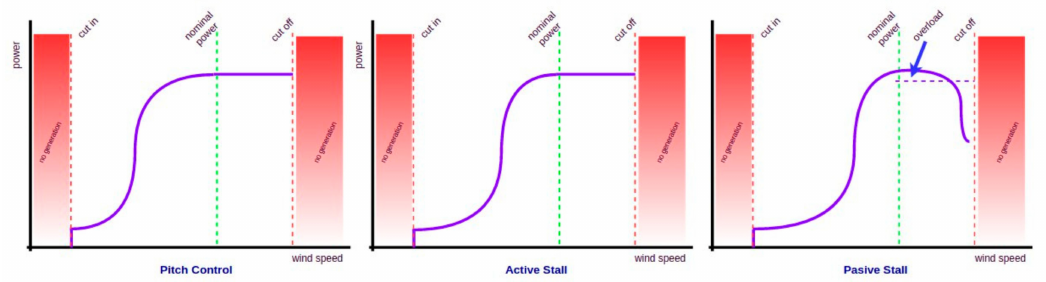
Figure 14. Di ff erent techniques of wind turbines